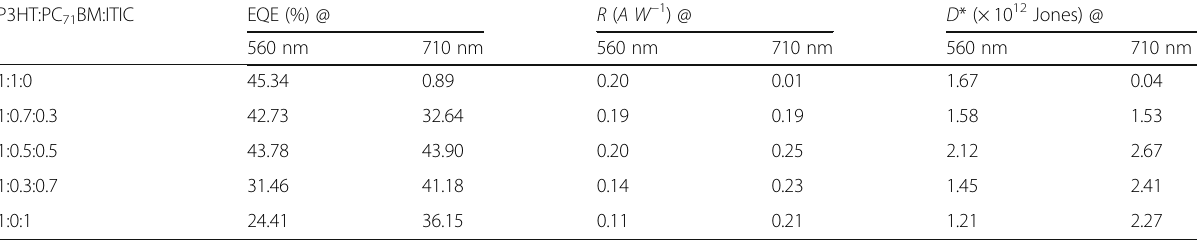
Table 1 Photodetective performance of obtained